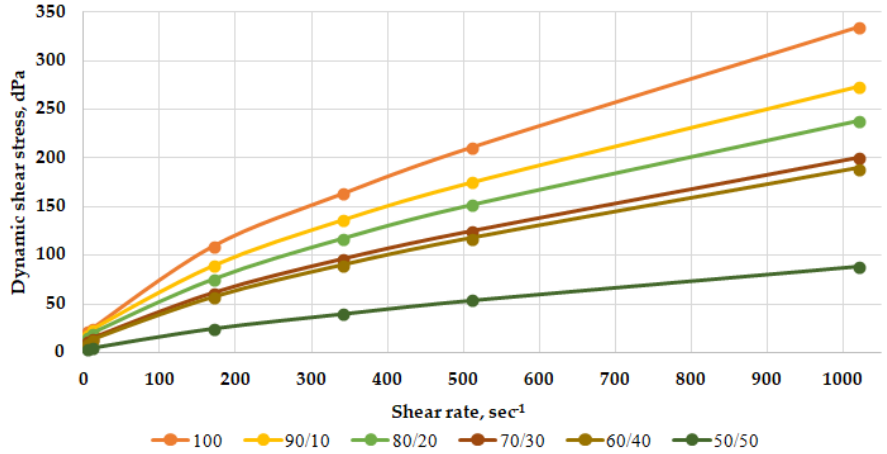
Figure 5. Rheological profiles of mixtures of heavy mud with brine depending on their ratio after heating at 60 ◦ C for 8